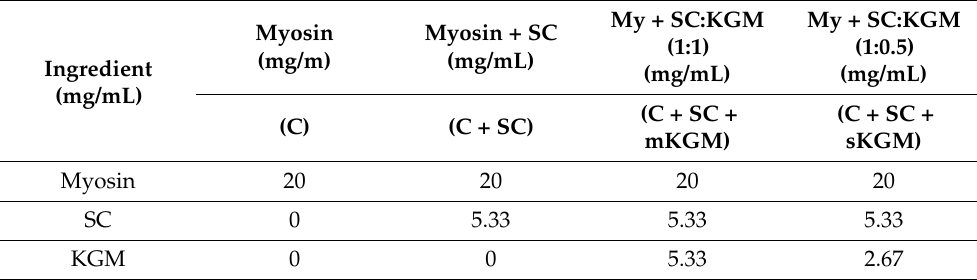
Table 1. Experimental design showing the final concentrations of the specific ingredients in the gelling